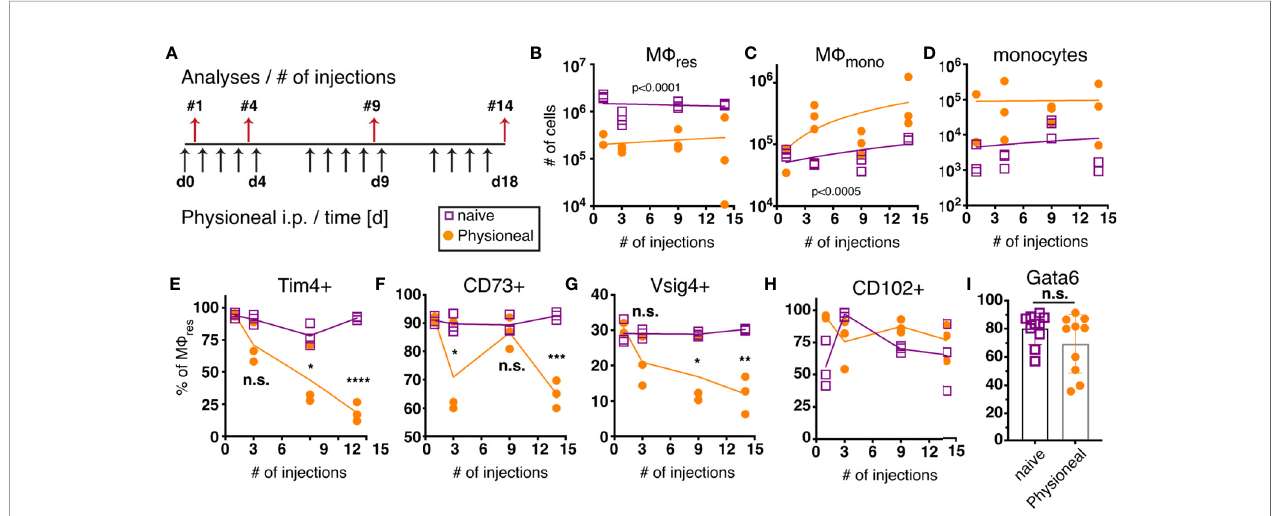
FIGURE 2 | Repeated injection of PD fl uid leads to a progressive change in M F res phenotype. C57BL/6 mice were injected with PD fl uid ( fi lled circle) or left untreated (open square) 5 times a week for the indicated number of injections. At each timepoint whole PEC were isolated 24 h after the last injection and analysed by fl ow cytometry. (A) Schematic depiction of experimental timeline. (B – D) Number of M F res, M F mono and Ly6C high monocytes. (E – H) Expression of M F res associated cell-surface markers on F4/80 high M F . (I) Intracellular expression of Gata6 in M F res identi fi ed in (A) . Datapoints depict individual animals and lines indicate (B – H) median or (I) mean with SD. Data from a single experiment using 3 animals per group per timepoint. Data analysed using 2-way ANOVA followed by Tukey ’ s post-hoc test after transformation. n.s., not signi fi cant; *p < 0.05; **p < 0.01; ***p<0.001; ****p < 0.0001.